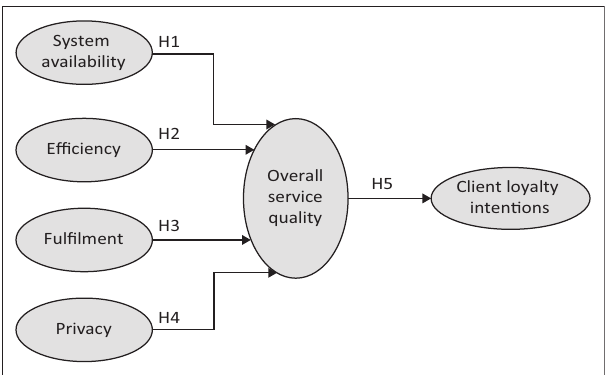
FIG URE 1: The conceptual